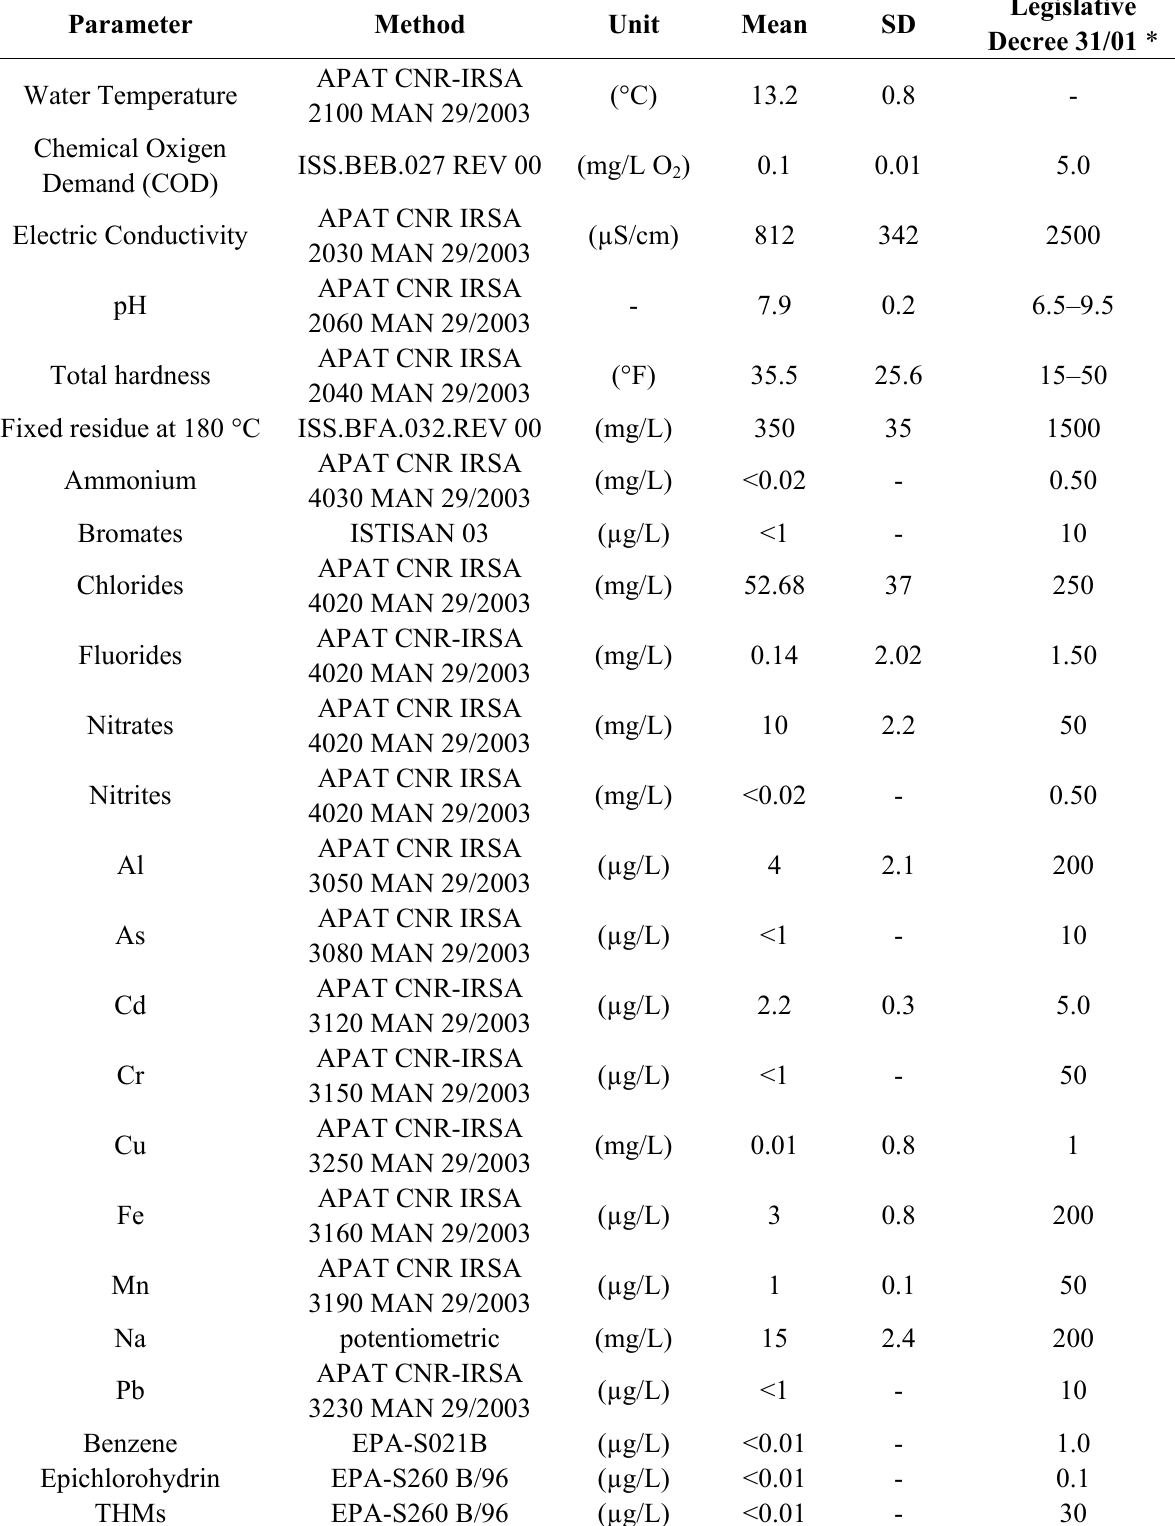
Table 1. Physical and chemical parameters relative to water samples collected in the tanks before